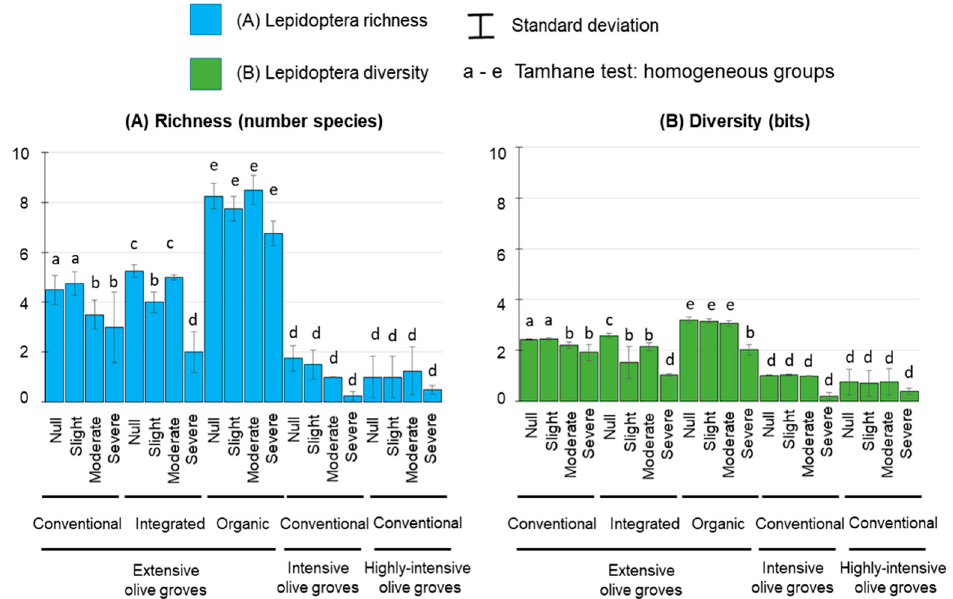
Figure 4. Mean values and standard deviations for lepidoptera richness ( A , number of species) and diversity ( B , bits) synthesized for each erosion level and type of olive grove. Indexes, a–e, indicate the classification groups generated in the Tamhane post-hoc test to establish similar categories.